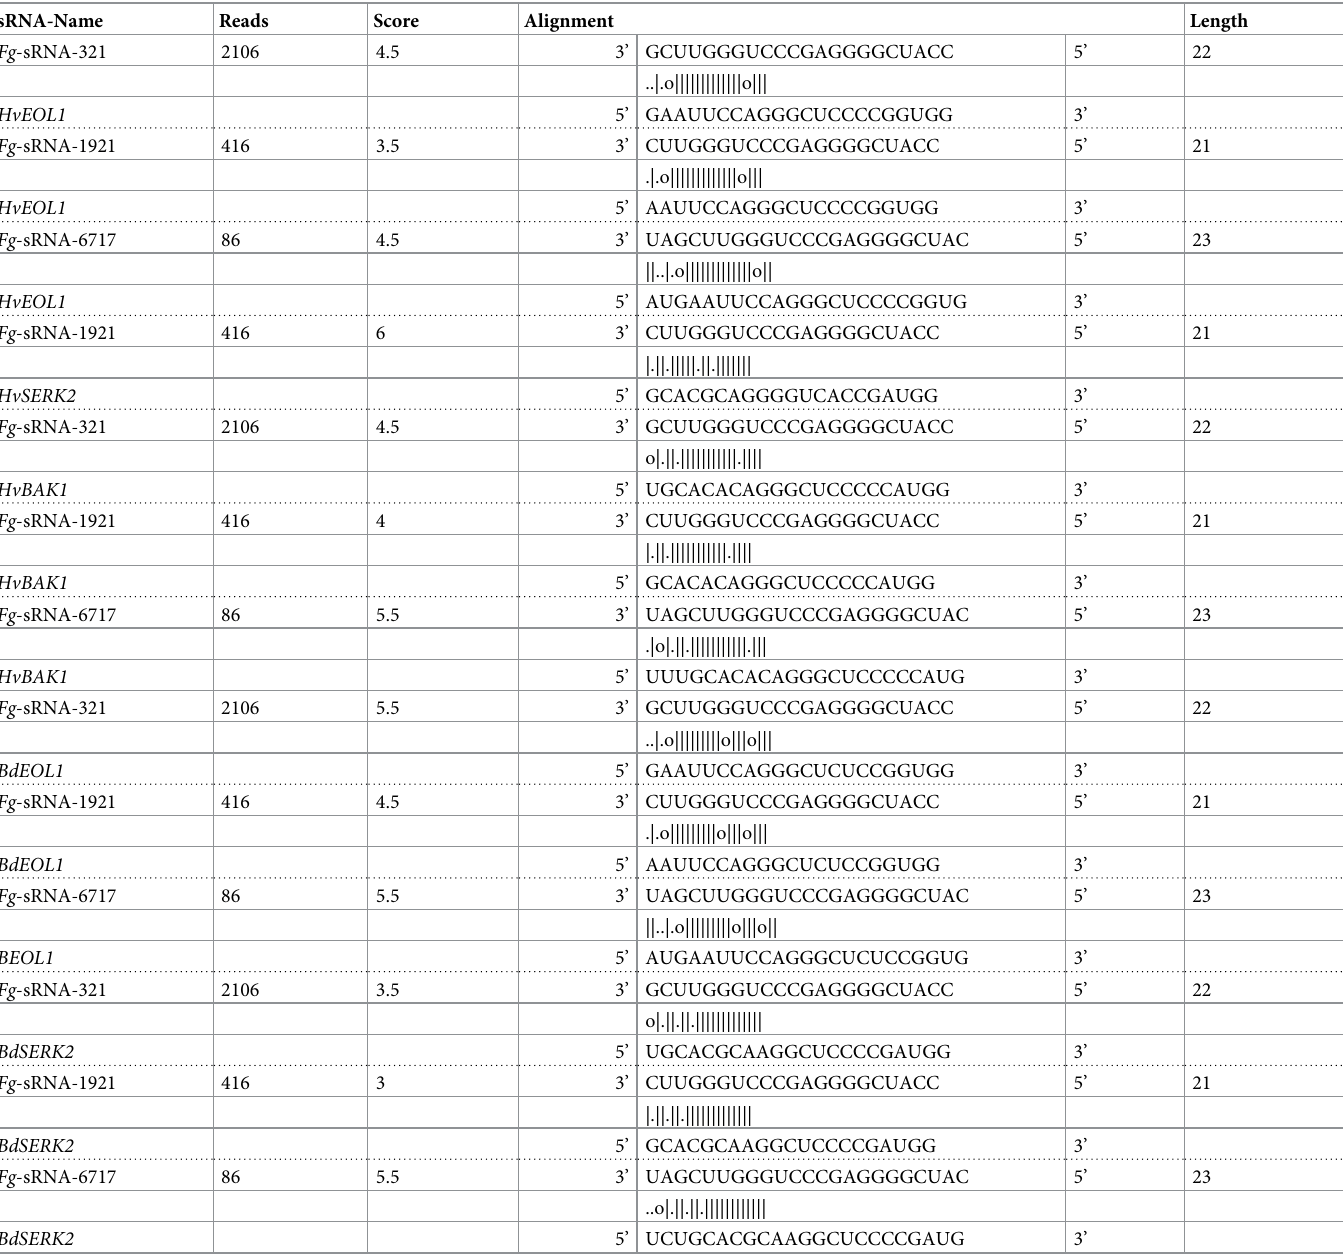
Table 2. Target prediction results of Fg -sRNAs with more than 400 reads in IFA65 axenic culture.